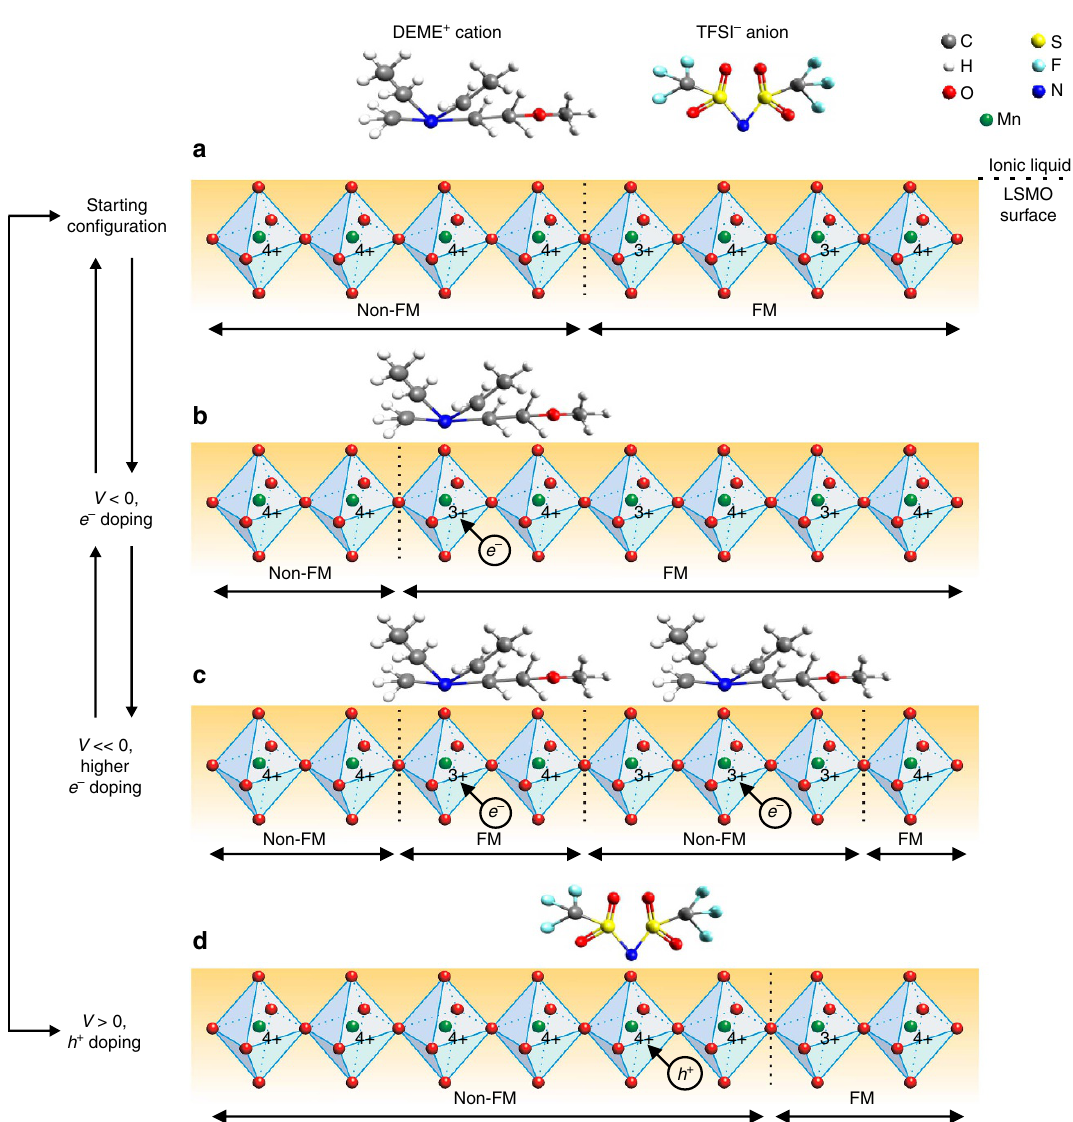
Figure 5 | Mechanism of electric field tuning of magnetoelectronic phase separation at the LSMO/ionic liquid interface. For the sake of clarity, not the entire perovskite unit cell of LSMO, but only the oxygen octahedron containing one Mn ion is shown. The sketches should be read together with the trend of the M ( Q ) curves in Fig. 4b. ( a ) Initial surface magnetoelectronic configuration of LSMO with two distinguished FM and non-FM domains. ( b ) Expansion of the FM domain on electron doping (optimization of Mn 3 þ /4 þ balance). ( c ) Shrinkage of the FM domain on further electron doping (increase in Mn 3 þ /3 þ balance). ( d ) Shrinkage of the FM domain on hole doping (increase in Mn 4 þ /4 þ